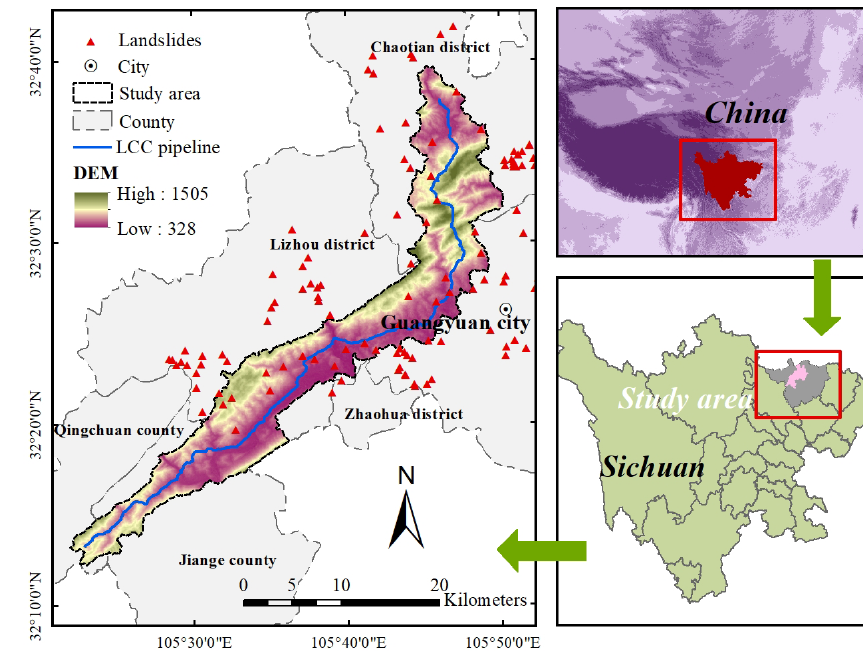
Figure 1. Landslide location map of the study